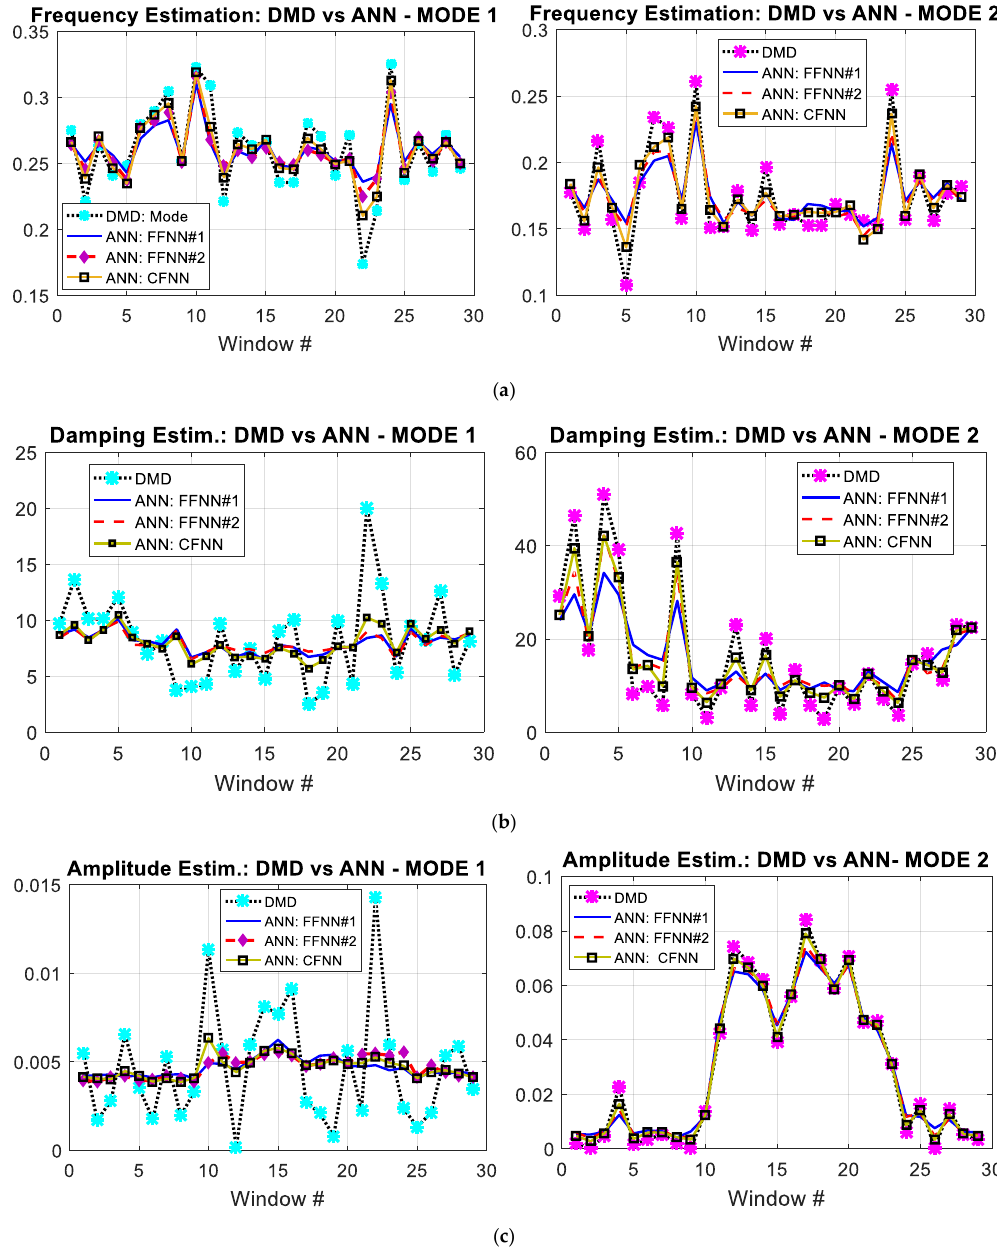
Figure 9. Comparison of the results obtained on the same dataset with different ANN architectures, according to the validation scenario VS#2: ( a ) frequency, ( b ) damping, ( c ) amplitude for mode #1 (left column) and mode #2 (right column).